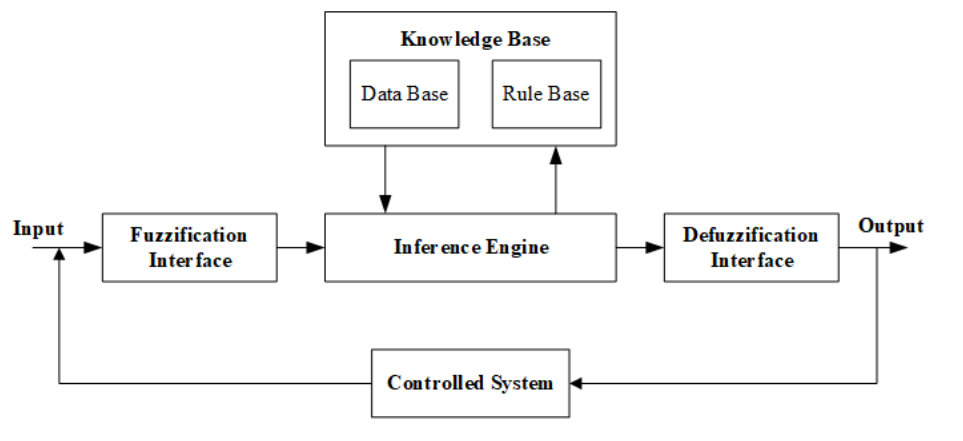
Figure 5. Structure of Fuzzy Logic Controller.